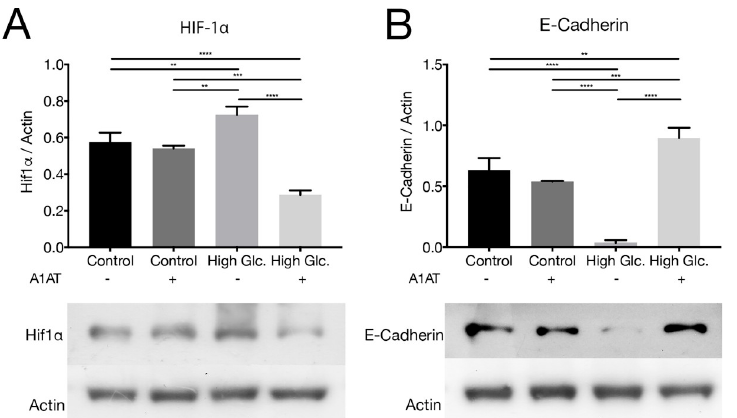
Fig 6. A1AT effect on mTOR and N-Cadherin mRNA. (A) RT-qPCR for MTOR mRNA, (B) RT-qPCR for CDH2 (N-Cadherin). High glucose group expressed as ‘High Glc’. Data expressed as fold change with respect to control mean ± SD. � p < 0.05, �� p < 0.01, ���� p < 0.0001 vs. Control.